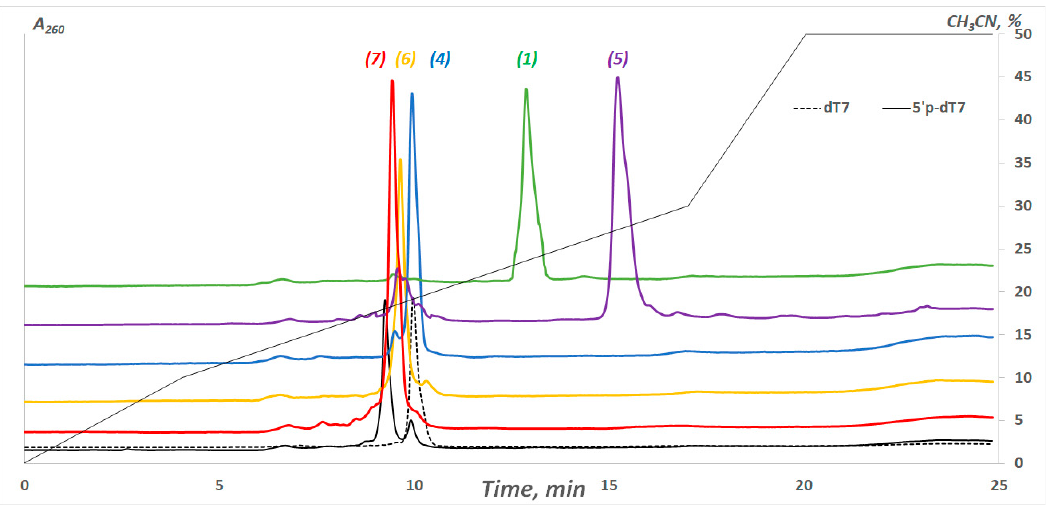
Figure 4. RP-HPLC analyses of reaction mixtures upon the conjugation of 5 ′ -p-dT 7 with different amino ligands (Table 1). dT 7 : 5 ′ -d(TTTTTTT); 5 ′ -p-dT 7 : 5 ′ -p-d(TTTTTTT); ( 1 ): MB - L 6 -NH-p-dT 7 ; ( 4 ): CH ≡